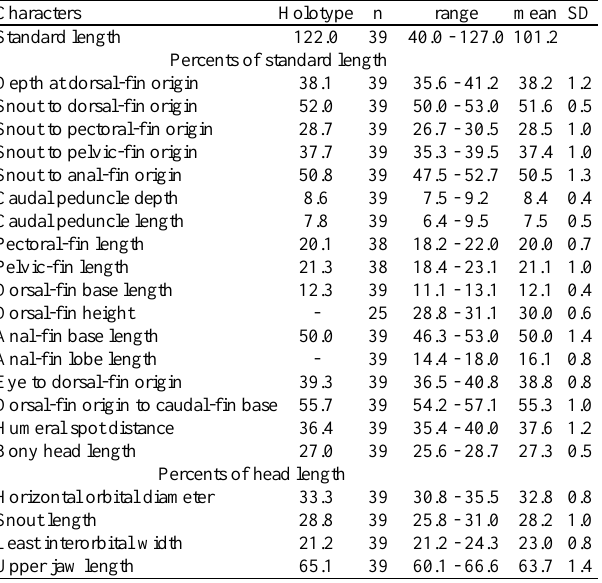
Table 11 . Morphometrics of Charax niger . Specimens are from MZUSP 31137, 81137, 81266, 81193, 87354,